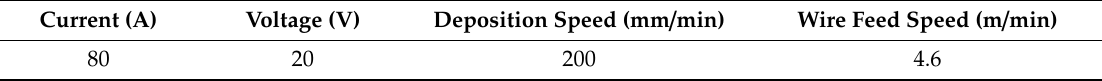
Table 1. Welding parameters used in the deposition.